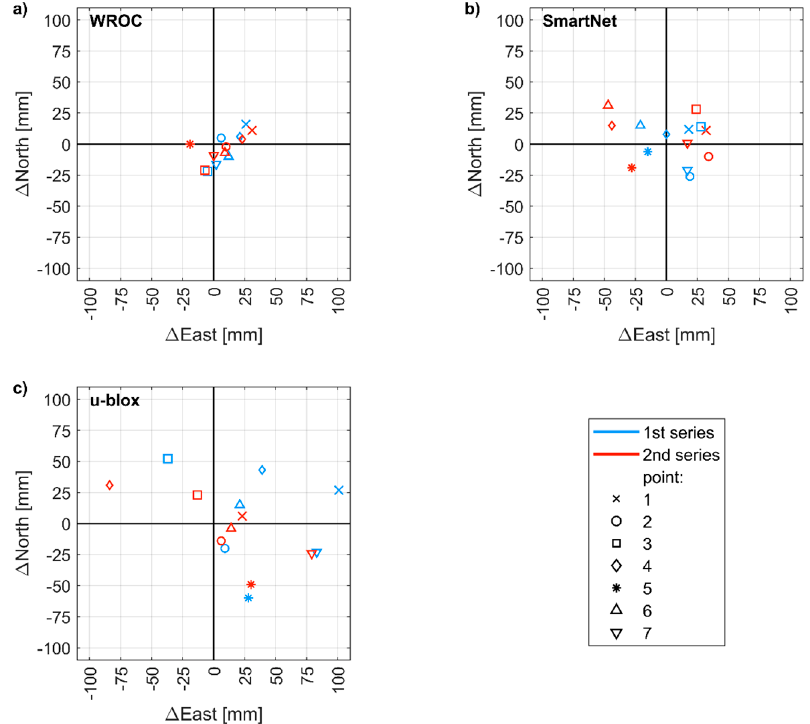
Figure 10. Positioning error (with respect to reference coordinates) of control points measured in two series by using: ( a ) WROC station as reference station; ( b ) Network Real-Time Kinematic (NRTK) SmartNet; ( c ) u-blox receiver as a base station.